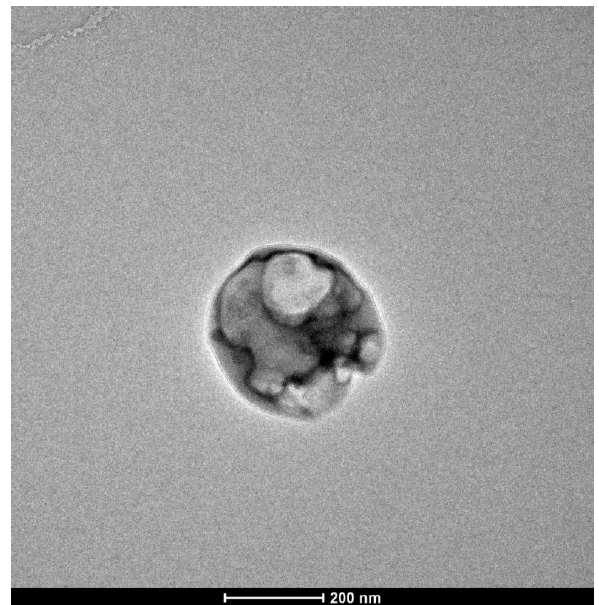
Figure 9. TEM image of an O-, S-, and K-containing particle ob- tained from an ascending gas flow in the soil from the Kafang cop- per deposit, Yunnan